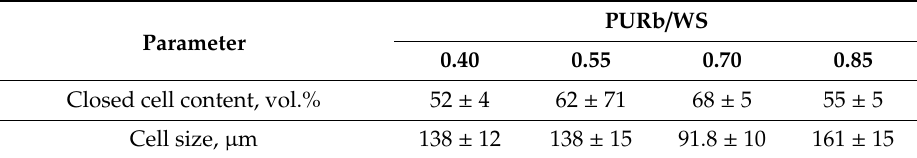
Table 4. Structural parameters of PUR biocomposite